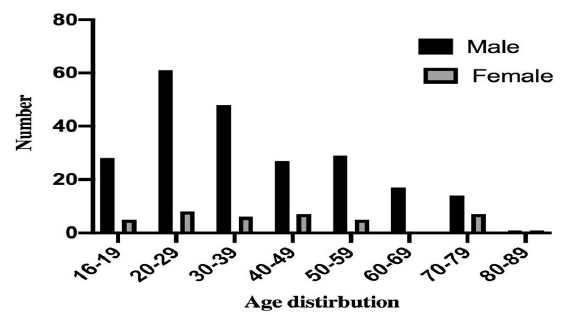
Figure 2. Distribution of age by